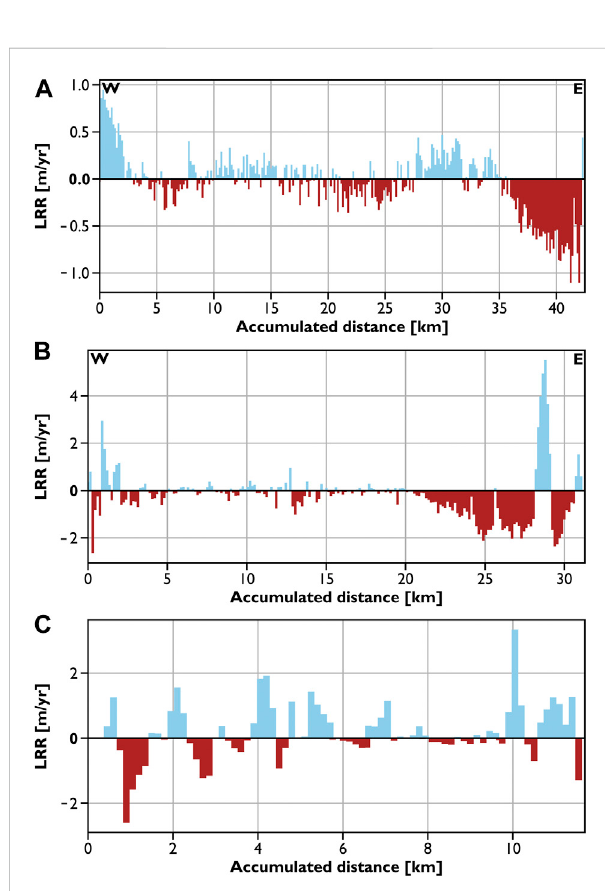
FIGURE 3 Shoreline change rates (1985 – 2021): (A) facing the open ocean; (B) back-barrier; (C) facing marambaia